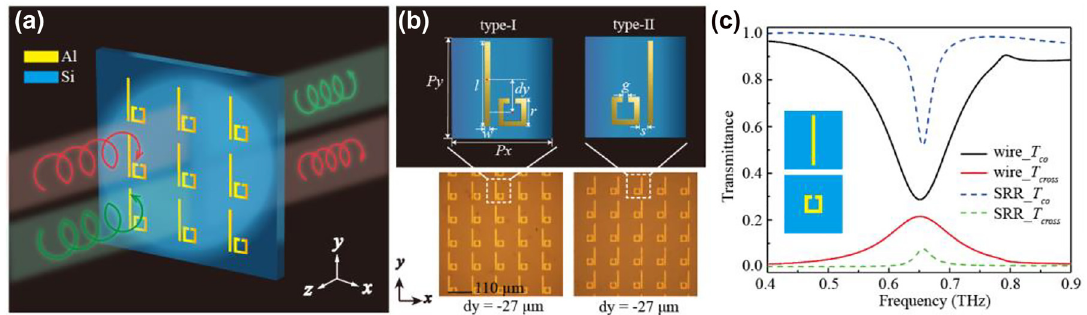
Figure 1: Schematic diagrams and the transmittance of the chiral metasurfaces. (a) Schematic diagram of the chiral metasurfaces. (b) Micrographs of type-I (left) and its mirror structure type-II (right) and their unit cells. (c) Simulated transmittance of bare wire and bare SRR in the unit cell under circularly polarized wave